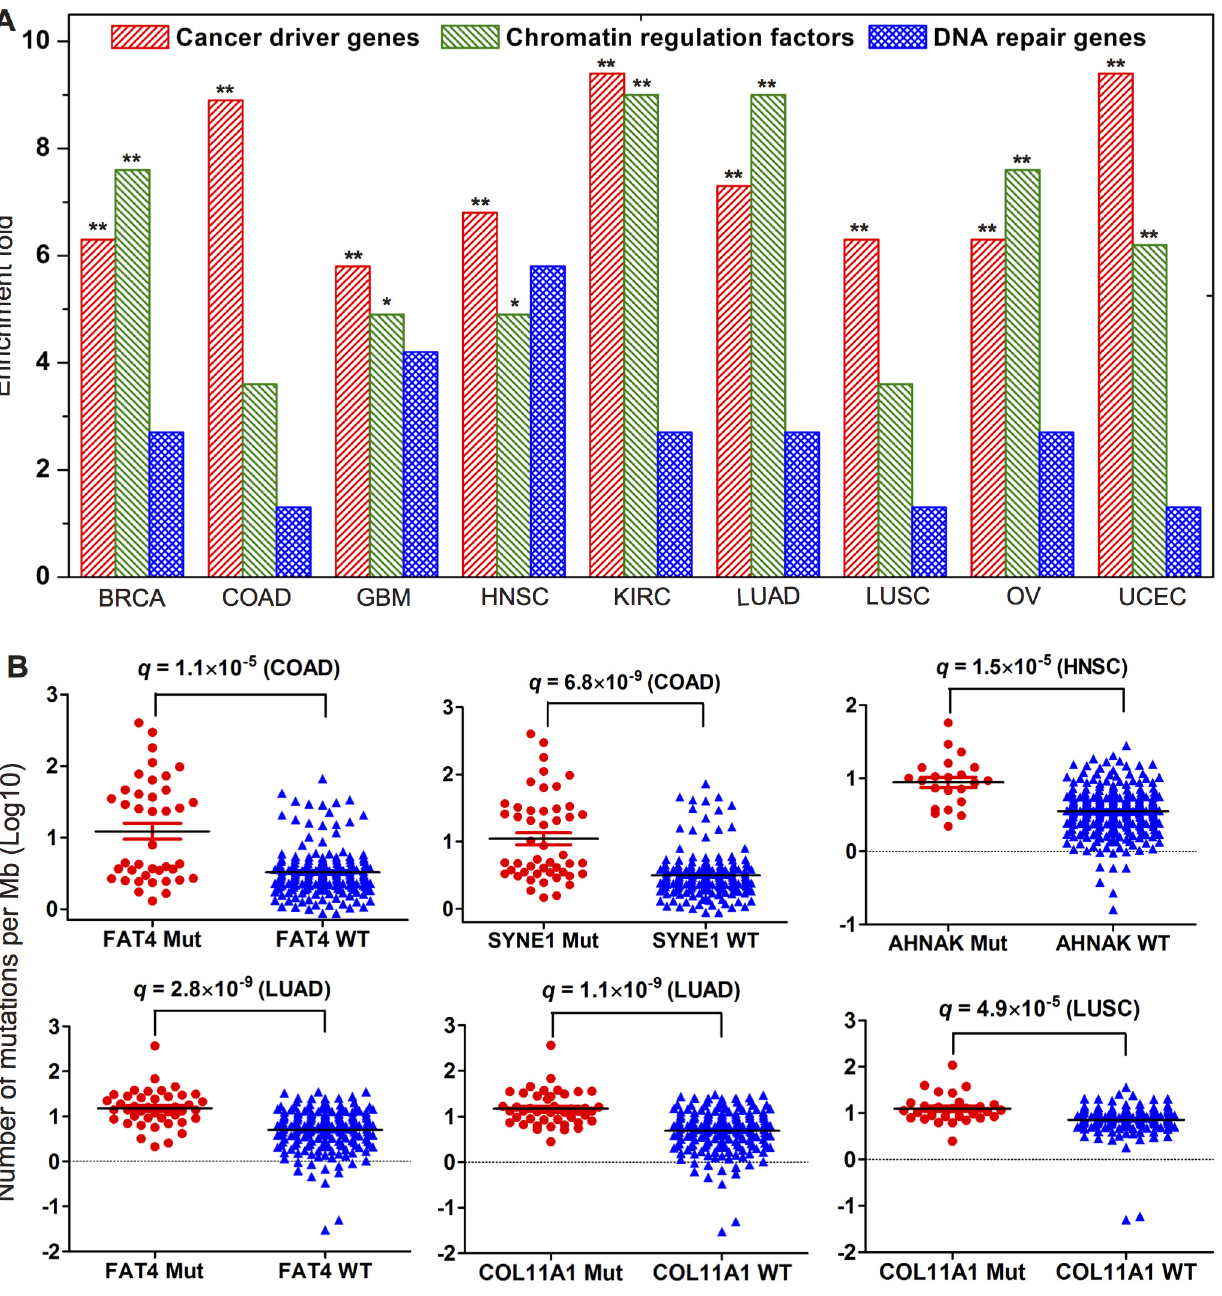
Fig 4. Identifying four putative cancer genes. ( A ) Enrichment analysis of the top 100 genes with the highest gene average gravitation scores for cancer driver genes, chromatin regulation factors, and DNA repairs genes. The adjusted p-values ( q ) are calculated by the Fisher ’ s exact test and corrected by Benjamini-Hochberg multiple testing. ** : q < 0.01, * : q < 0.05. The detailed data is provided in S9 and S11 and S12 Tables. ( B ) Distribution of the number of mutations per megabase pairs (Mb) for the mutated (Mut) tumor samples versus wild-type (WT) samples. The q values are calculated by the Wilcoxon rank- sum test and corrected by Benjamini-Hochberg multiple